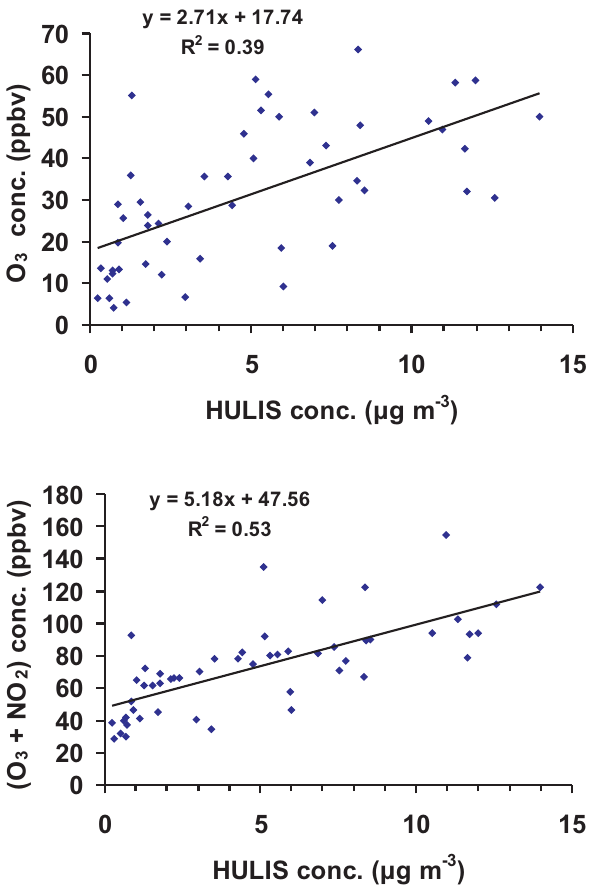
Fig. 5. Correlations between HULIS concentrations and ozone (top) and (O 3 +NO 2 ) concentrations (bottom) measured at the urban